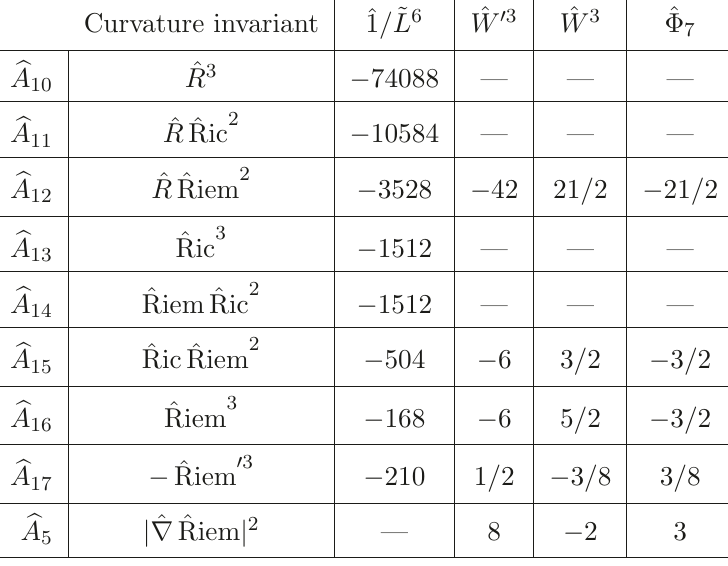
Table 4 . 7D basis of cubic curvature